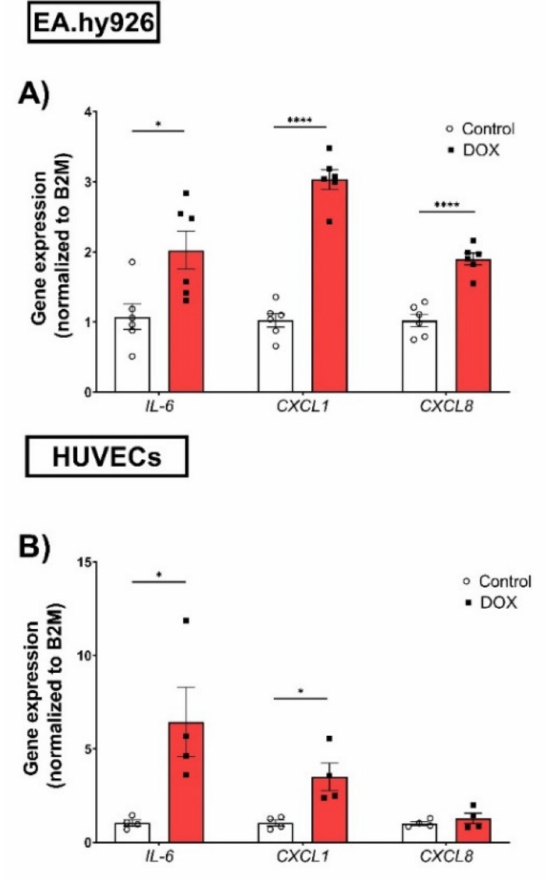
Figure 3. DOX induces the gene expression of SASP factors in both EA.hy926 cells and HUVECs. EA.hy926 human-endothelial-derived cells and HUVECs were treated with DOX (0.5 µ M) for 24 h. Thereafter, DOX was removed and cells were incubated with DOX-free media for 72 h. The total RNA was then extracted and the mRNA expression of SASP factors including IL-6, CXCL1, and CXCL8 in ( A ) EA.hy926 cells ( n = 6) and ( B ) HUVECs ( n = 4) was determined by real-time PCR. Values were normalized to B2M and expressed relative to control cells. Values are shown as means ± SEM. Data were analyzed by unpaired two-tailed t-test. Note: * p < 0.05, **** p <